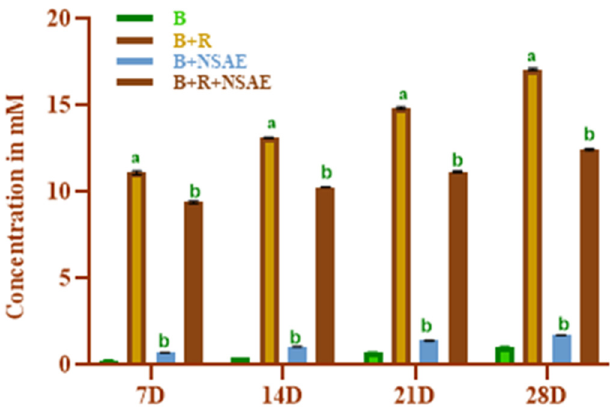
Figure 5. The effect of NSAE on the formation of ketoamine in the BSA+D-ribose system. B-BSA, B+R=BSA+Ribose, B+NSAE=BSA+ Nigella sativa aqueous extract, and B+R+NSAE= BSA+Ribose+ Nigella sativa aqueous extract. Results are represented as mean ± SD ( n = 5). a p < 0.05 when compared to BSA and b p < 0.05 when compared to BSA+D-ribose.